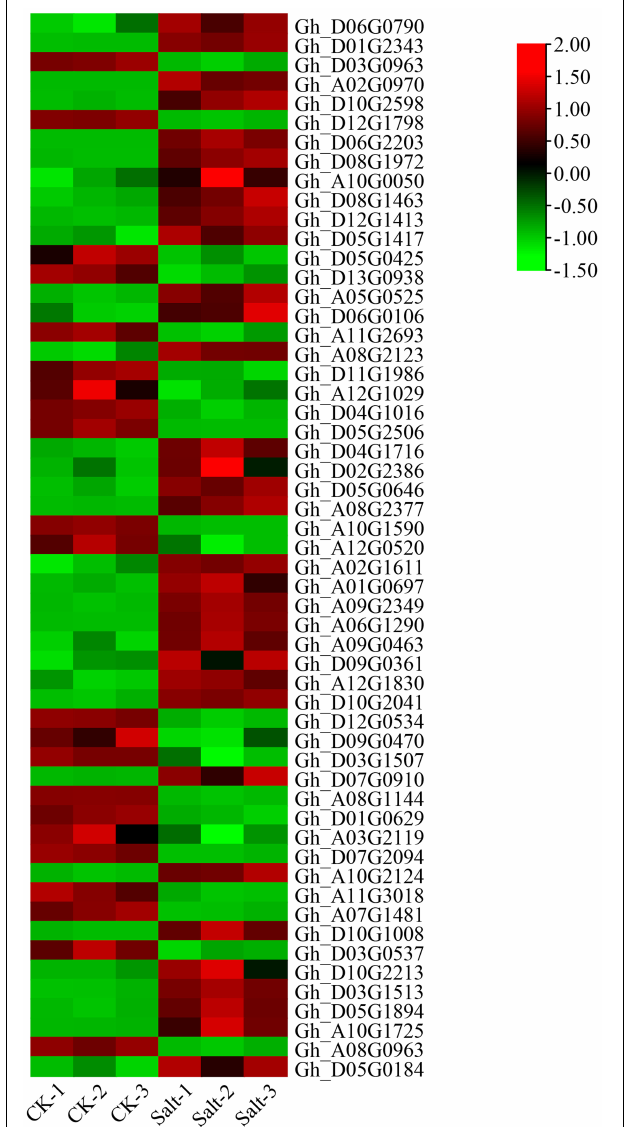
FIGURE 6 | Expression patterns of the P450 family genes in the salt-tolerant transcriptome of upland cotton “Tongyan No.